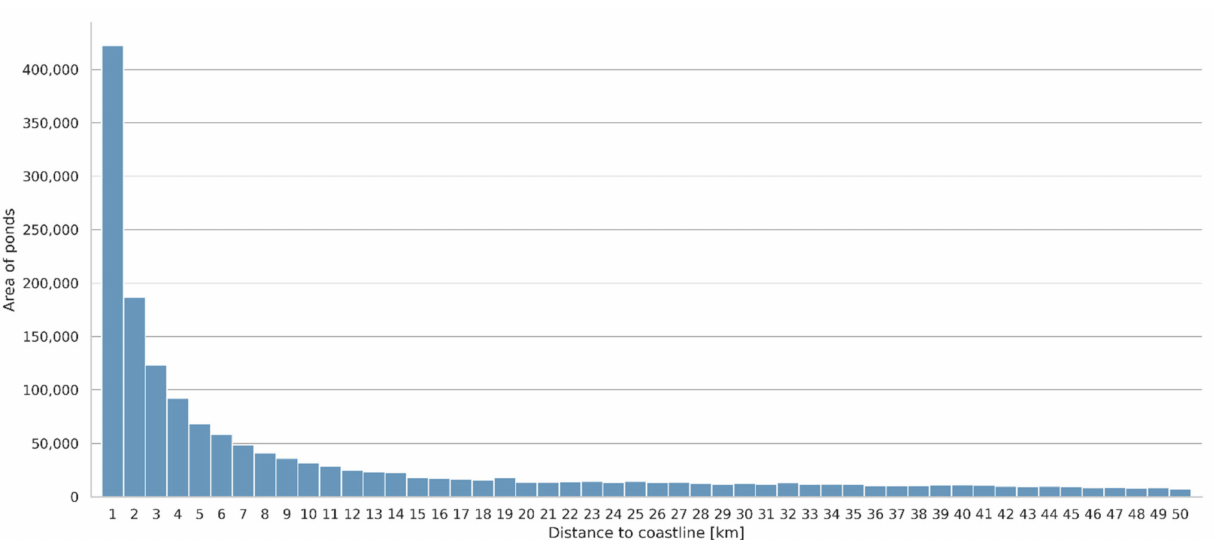
Figure 10. Total area of Earth-observation-derived aquaculture ponds per kilometer distance to the